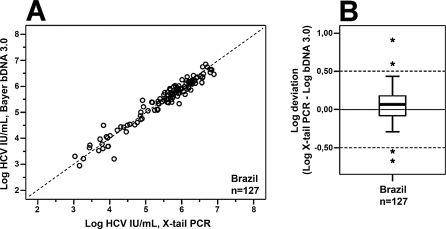
Results Obtained with X-Tail Viral Load Monitoring, Implemented in Brazil127 samples were measured in a Brazilian HIV-1 viral load monitoring centre by Bayer VERSANT 3.0 HCV bDNA assay and by X-tail in-house PCR. (A) Correlation of viral loads between X-tail RT-PCR (x-axis) and Bayer bDNA 3.0 (y-axis). The dashed line represents an ideal correlation. Pearson's bivariate correlation coefficient was 0.97.(B) Quantitative differences. The box shows the median and interquartile range (box length). The whiskers represent an extension of the 25th or 75th percentiles by 1.5 times the interquartile range. Datum points beyond the whisker range are considered as outliers and marked as asterisks.